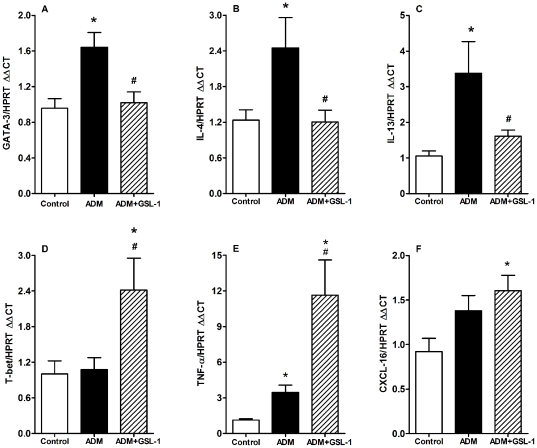
GSL-1 treatment modulates the ADM-induced Th2-like cytokine profile and induces a pro-Th1 environment.BALB/c mice were injected at day 0 with 10 mg/kg of adriamycin (ADM) or treated concomitantly with ADM and 5 µg/mouse GSL-1 (ADM+GSL-1). The ADM mice had increased levels of mRNA for the Th2-related transcription factor GATA3 (A), reflecting increased transcript levels for IL-4 (B) and IL-13 (C). In contrast, GSL-1 treatment inhibited these transcripts in association with an increase in the levels of mRNA for T-bet (D), a transcription factor associated with Th1 responses, TNFα (E) and the chemokine ligand CXCL16 (F). Thus, these data corroborate the idea that ADM-induced FSGS is associated with a Th2-like profile that can be inhibited by GSL-1 treatment and the generation of a pro-Th1 environment. * p<0.05 vs. control; # p<0.05 vs. ADM.